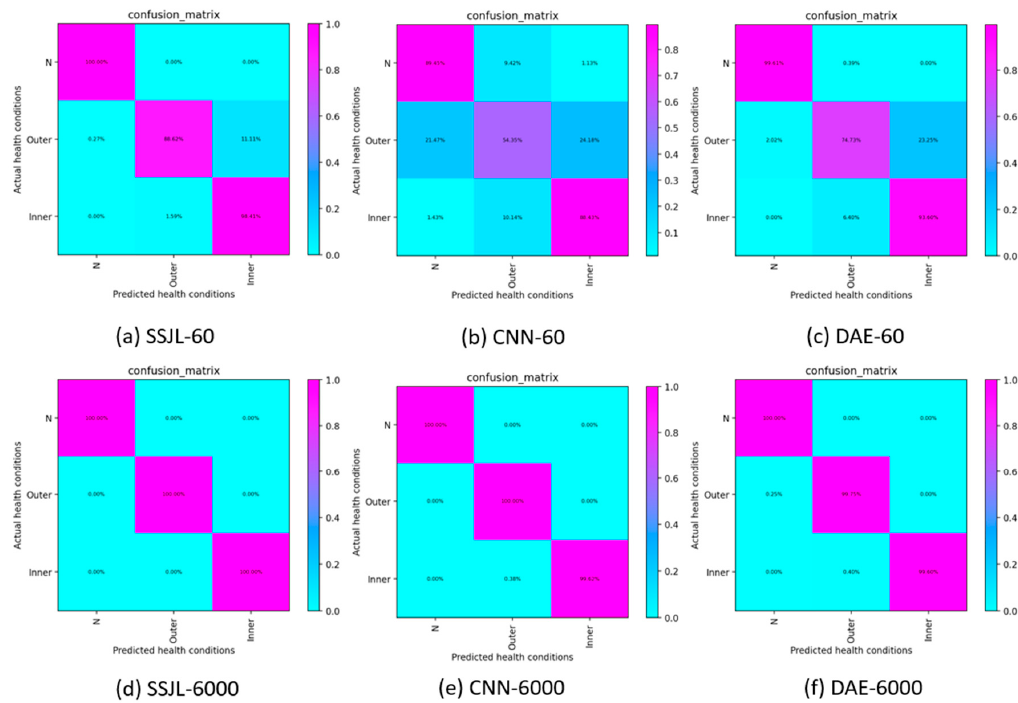
Figure 15. Confusion matrix on testing samples of the MFPT dataset: ( a ) SSJL-60, ( b ) CNN-60, ( c ) DAE-60, ( d ) SSJL-6000, ( e ) CNN-6000, and ( f ) DAE-6000.